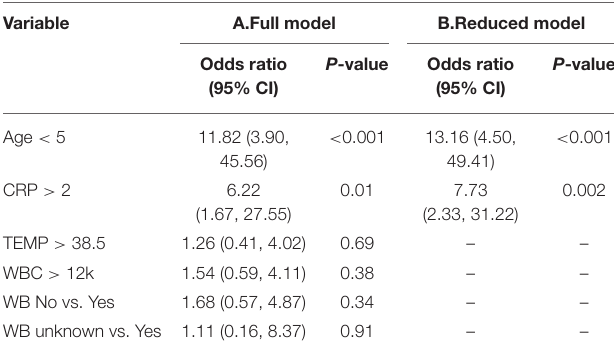
TABLE 2 | The logistic regression results, septic knee (n = 83) vs. aseptic knee (n = 34), a new septic knee model with (A) all pre-specified variables and (B) reduced set of